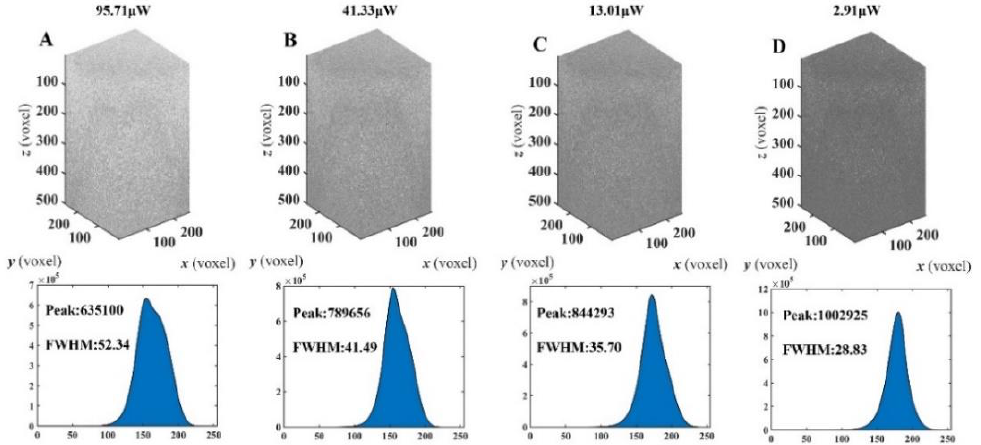
Figure 7. OCT images ( A – D ) with different reference arm light intensities (95.71 µ W, 41.33 µ W, 13.01 µ W, 2.91 µ W) and the corresponding histograms.